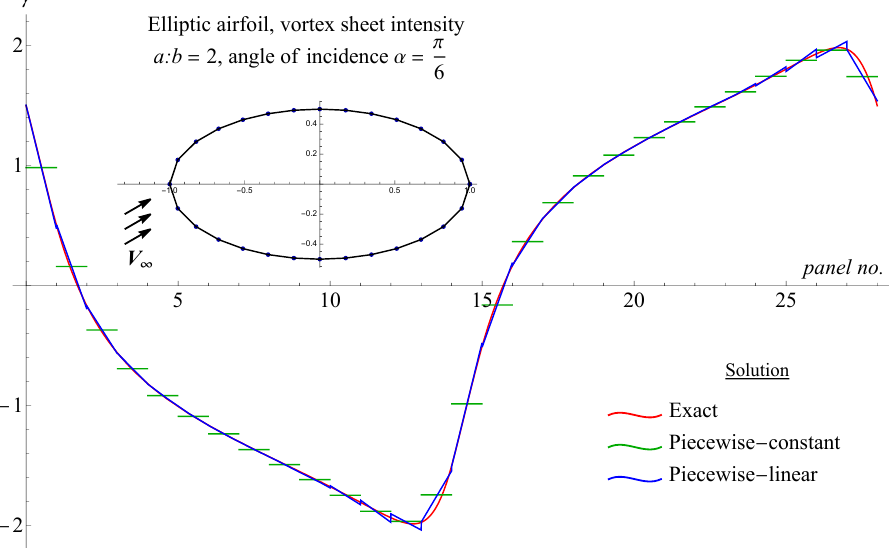
Figure 2. Elliptical airfoil with 2:1 semiaxes ratio at angle of incidence α = π /6; discretization is very coarse, number of panels N p = 28. Free vortex sheet intensity is shown for potential flow: exact distribution (red), piecewise-constant (green), and piecewise-linear (blue)